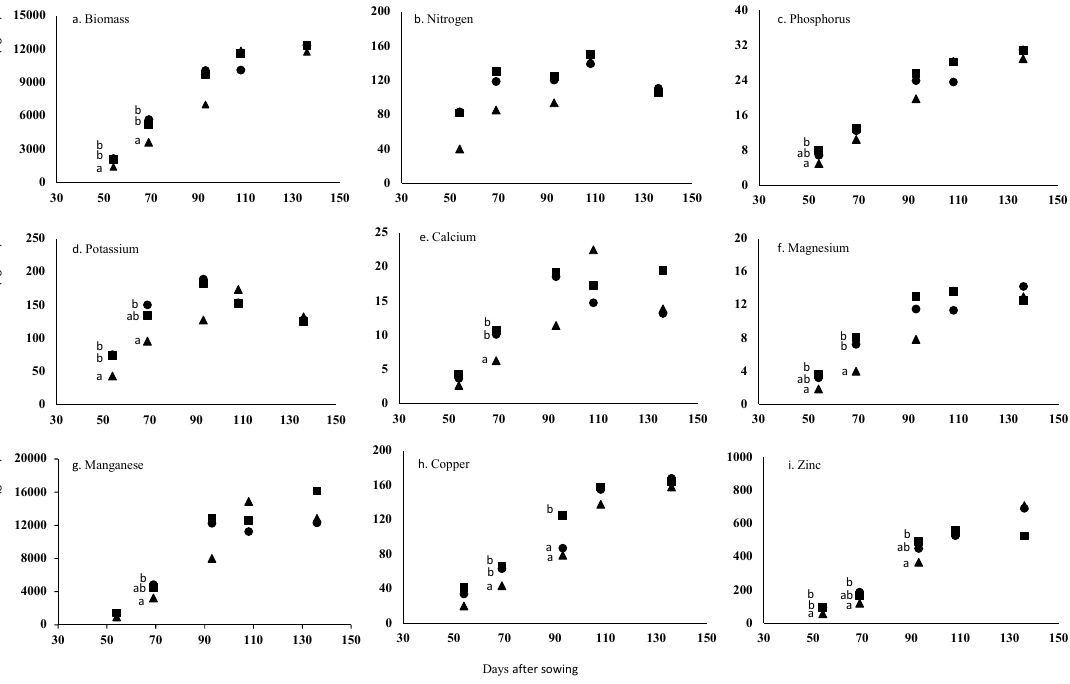
Figure 1. Accumulation of biomass ( a ), nitrogen ( b ), phosphorus ( c ), potassium ( d ), calcium ( e ), magnesium ( f ), manganese ( g ), copper ( h ) and zinc ( i ) throughout the growing season in shoots of rice fertilized with urea (circles), urea + urea ‐ 3,4 ‐ dimethylpyrazole phosphate (DMPP) (squares) or polymer ‐ coated urea (triangles). Treatments that do share a common letter within a given harvest (timepoint) are not significantly different at a p ≤ 0.05. The absence of any letters at a given harvest (timepoint) indicates no significant differences among treatments.